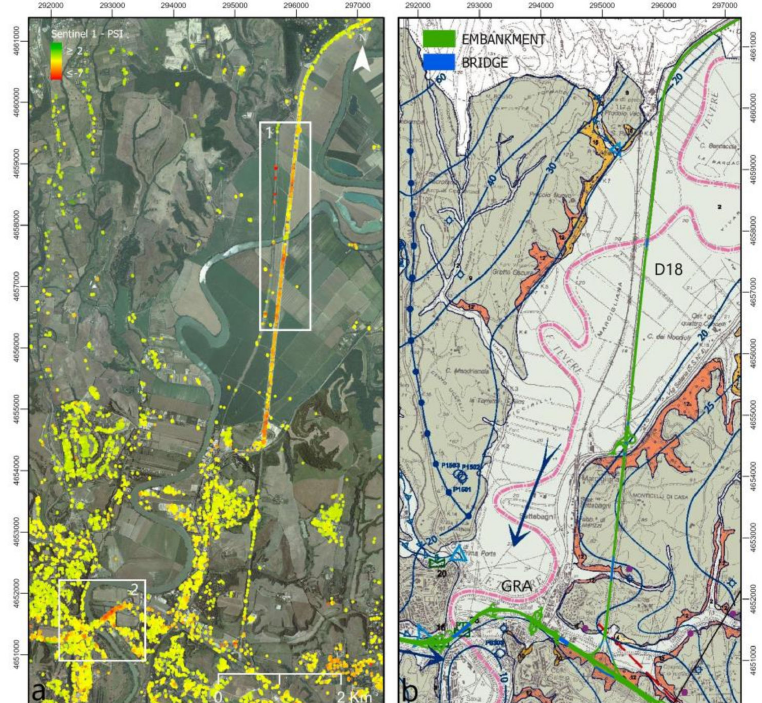
Figure 4. ( a ) Displacement map PSI Sentinel-1 and study area indicated in white boxes 1 and 2, as background orthophoto Rome, ( b ) Detail of the position of the D18 and GRA highway on the hydrogeological map of Rome (Vigna et al., 2015) shows the position of the route in the alluvial deposit in the northern area, southern zone volcanic deposit, (blue arrow) indicates the groundwater flow, (pink line) indicates the current course of the Tiber